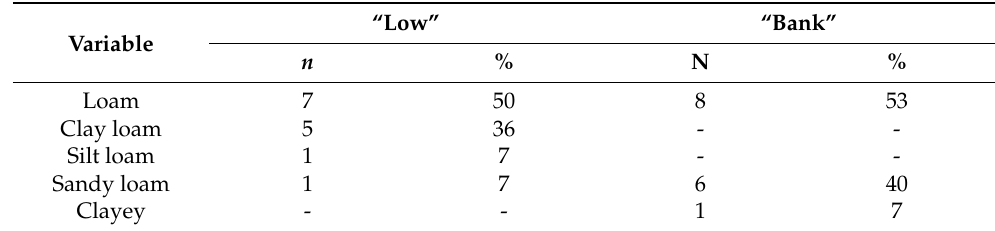
Table 3. Classification of soil texture according to physiographic position (“low” and “bank”) of Araucanian flooded-savanna soils (Arauca, Colombia,